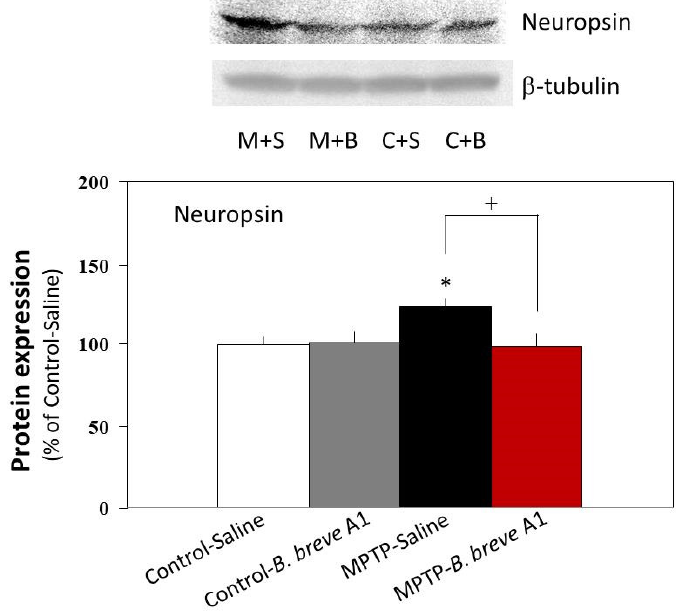
Figure 8. Neuropsin protein expression levels in saline-administered controls and PD mice, and in B. breve A1-administered controls and PD mice. The images show representative results (upper: neuropsin, lower: β -tubulin). The protein levels were normalized to β -tubulin as a loading control. Results are shown as a percentage of protein expression levels in Control + Saline. Data are expressed as the mean ± SEM: n = 5 per group. * p < 0.05 vs. Control + Saline and † p < 0.05: between MPTP + Saline and MPTP + B. breve A1.